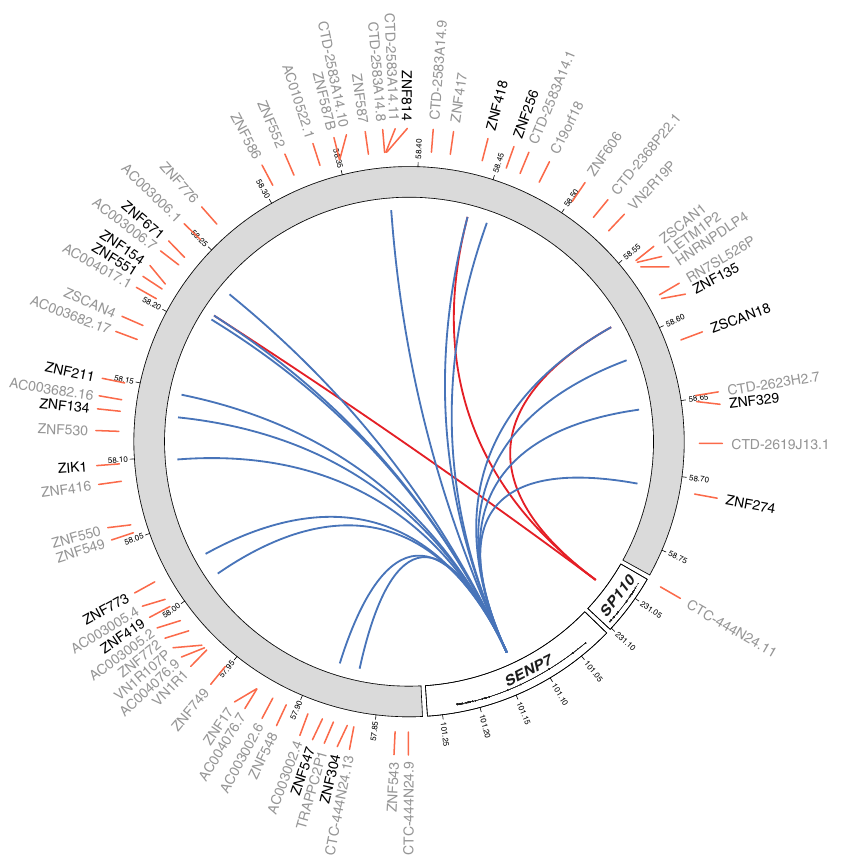
Fig. 3 SENP7 (chromosome 3) and SP110 (chromosome 2) affect a zinc fi nger cluster located on chromosome 19. Many of these genes are involved in retroviral repression, among others. Blue lines indicate a positive association (upregulation), red lines indicate a negative association (downregulation). Colouring indicates consistent opposite effects of SENP7 and SP110 on their shared target